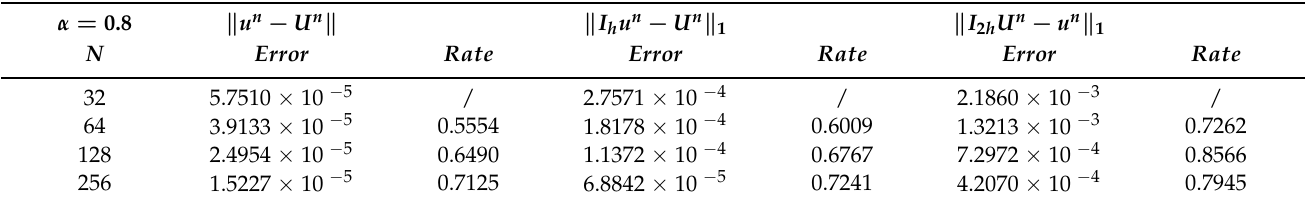
Table 1. Temporal numerical results of r = 1 on graded meshes to Example 1.